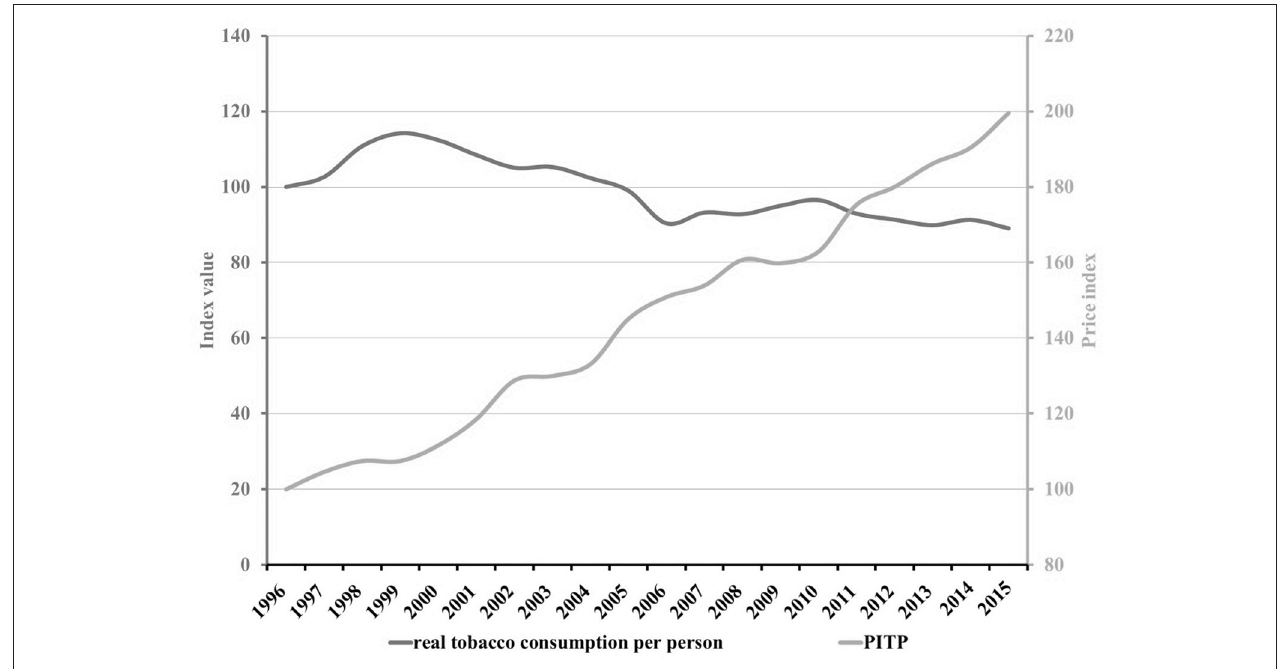
FIGURE 1 | Trends of the consumption expenditure of tobaccos per person and the wholesale price index of tobacco products (PITP)